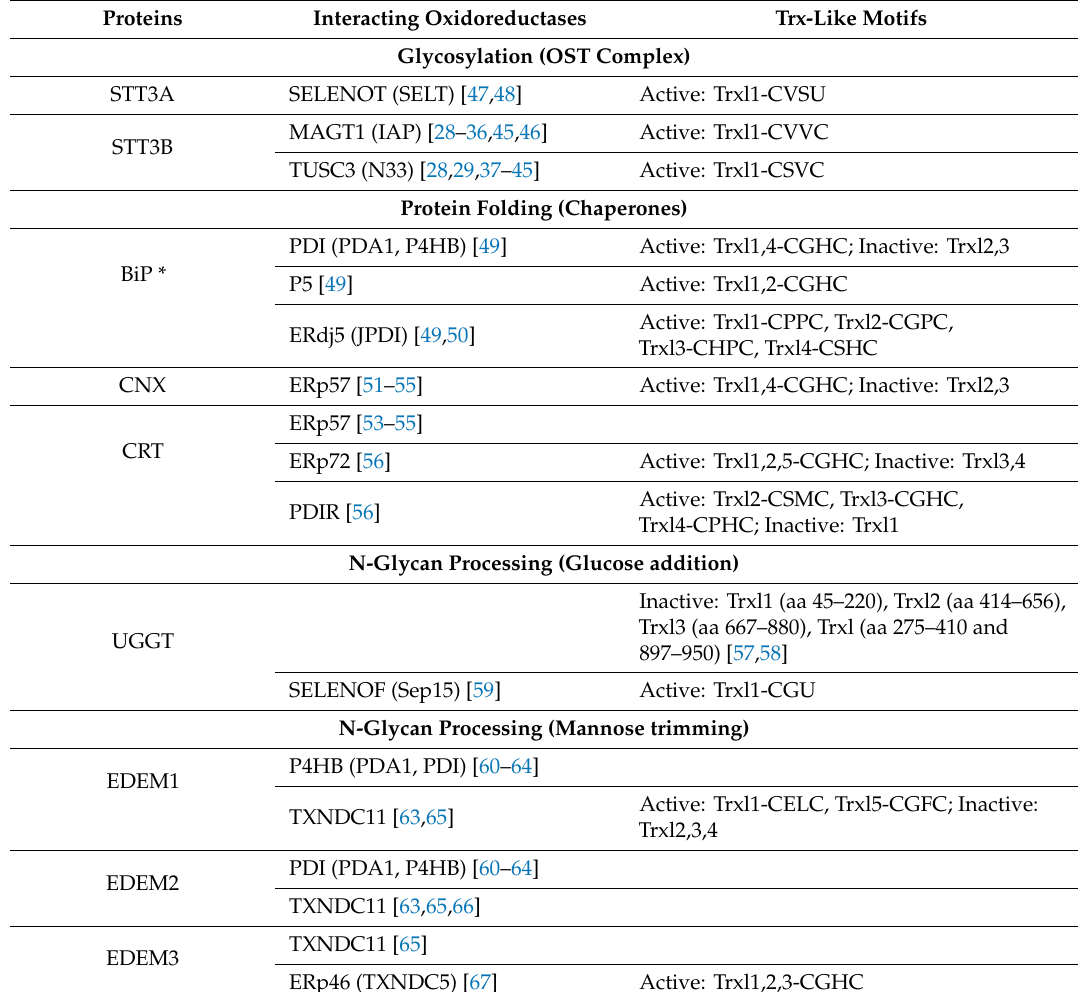
Table 1. A list of oxidoreductases interacting with the glycoprotein processing and folding machinery. Glycoprotein biosynthesis in mammalian cells is separated into di ff erent processes, glycosylation, folding, N-glycan processing, ER–Golgi tra ffi c, and ER associated degradation (ERAD). For each process, the specific proteins and their interacting oxidoreductase(s) are shown in the table. Respective thioredoxin-like (Trxl) domains and catalytic or non-catalytic motifs are